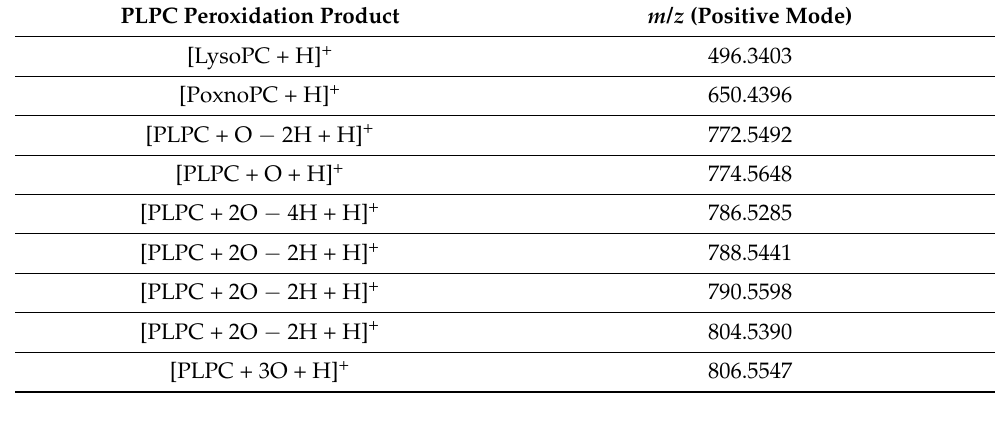
Table 2. PLPC peroxidation products after 30 min plasma treatments of lipid bilayers, observed by